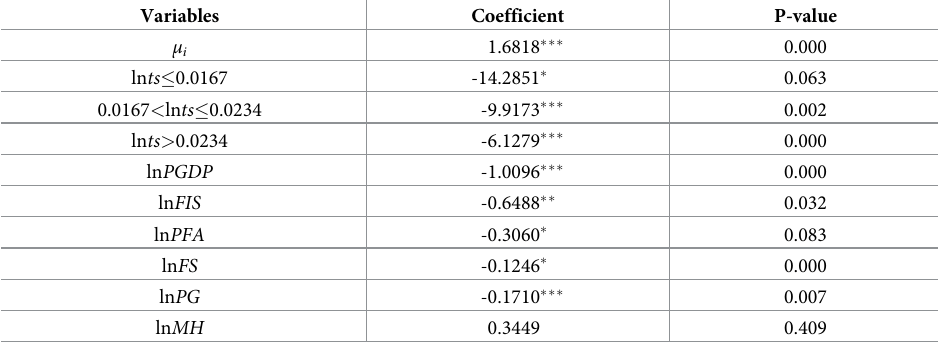
Table 9. Regression results of poverty level expressed by poverty